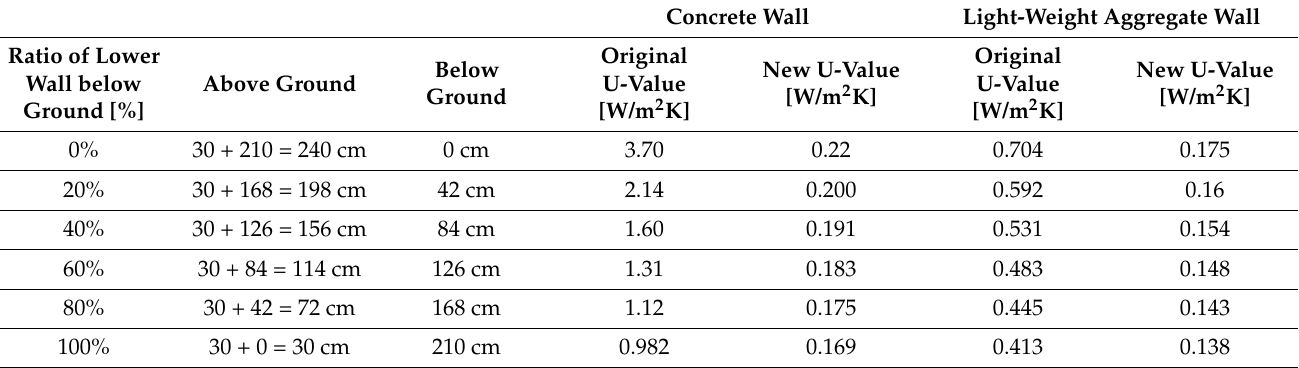
Table 3. U-values of basement walls used in the energy calculations, calculated according to NS-EN ISO 13370:2017 Thermal performance of buildings—heat transfer via the ground—calculation